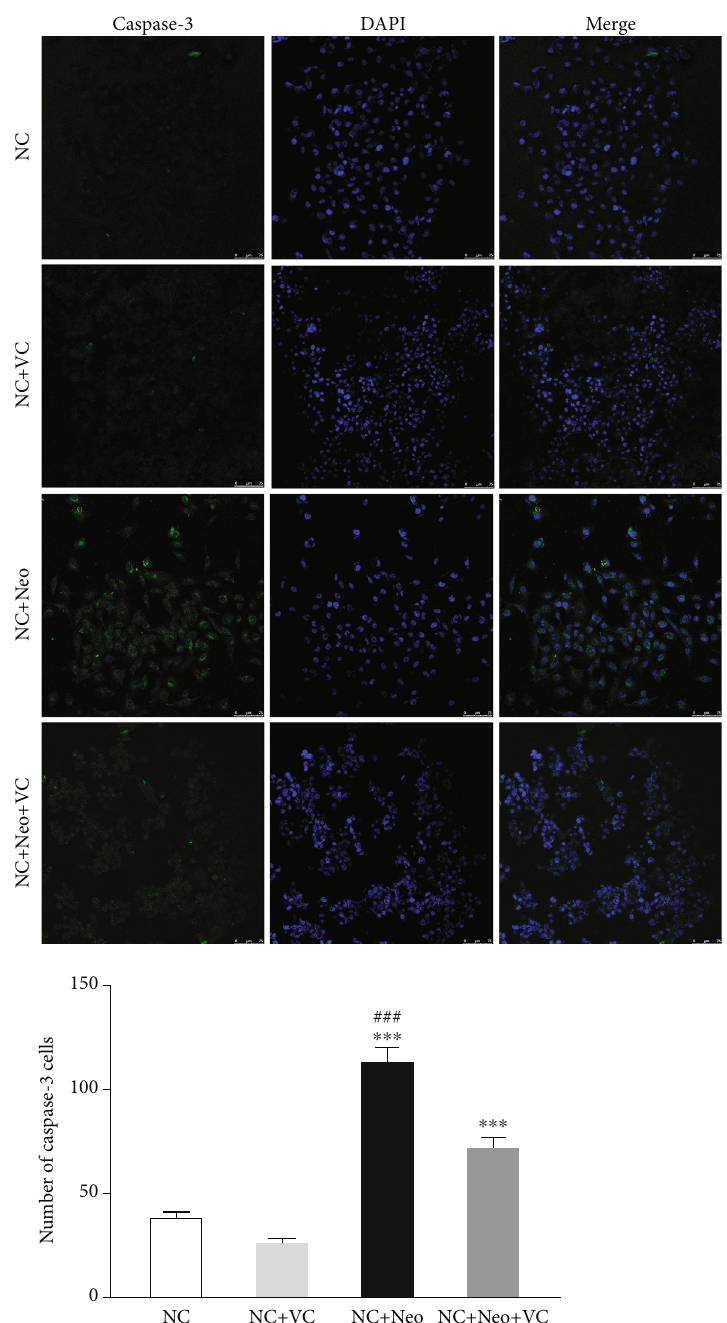
Figure 8: The expression of caspase-3 on VC and neomycin-treated HEI-OC1 cells. Caspase-3 was detected by immunostaining (green), scale bar = 10 μ m. The caspase-3-positive staining cells were observed after neomycin exposure compared to the control and VC groups. The number of positive staining cells shows a signi fi cant di ff erence with di ff erent treatment. One-way ANOVA, ∗∗∗ p < 0 : 001 versus NC group and ### p < 0 : 001 versus NC+Neo+VC group. All tests were repeated three times